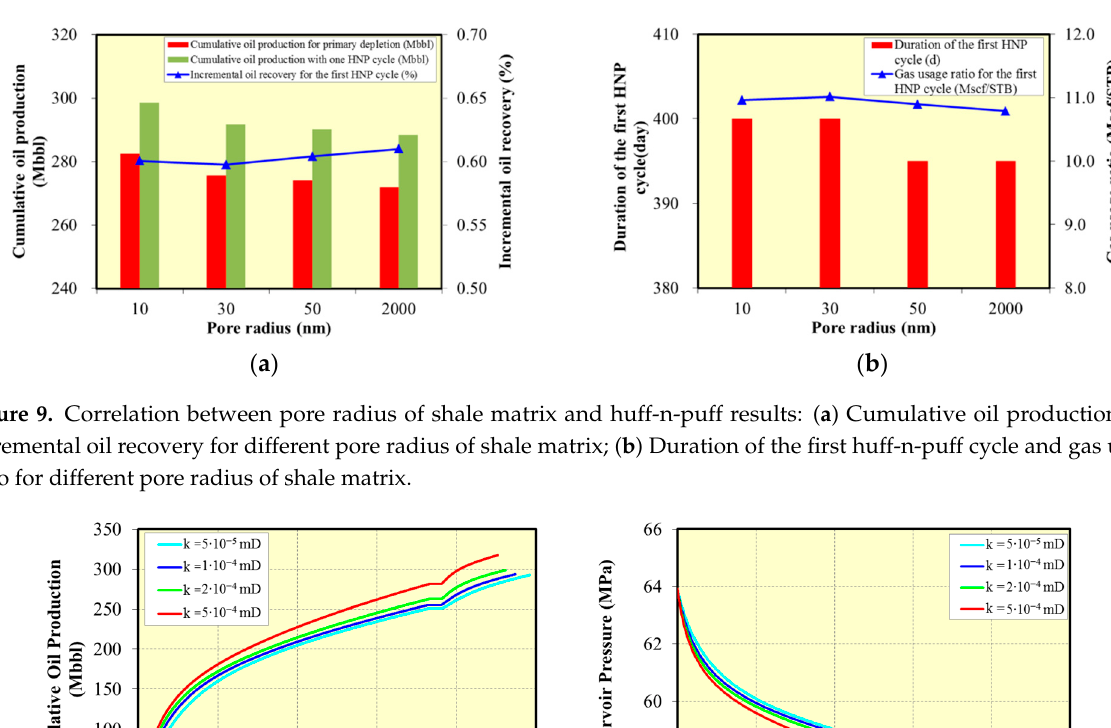
Table 10. Summary of results for huff-n-puff with different matrix permeability.